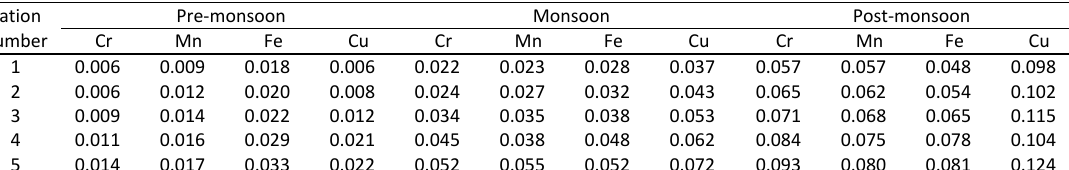
Table 5: Contamination factor of collected samples during various seasons